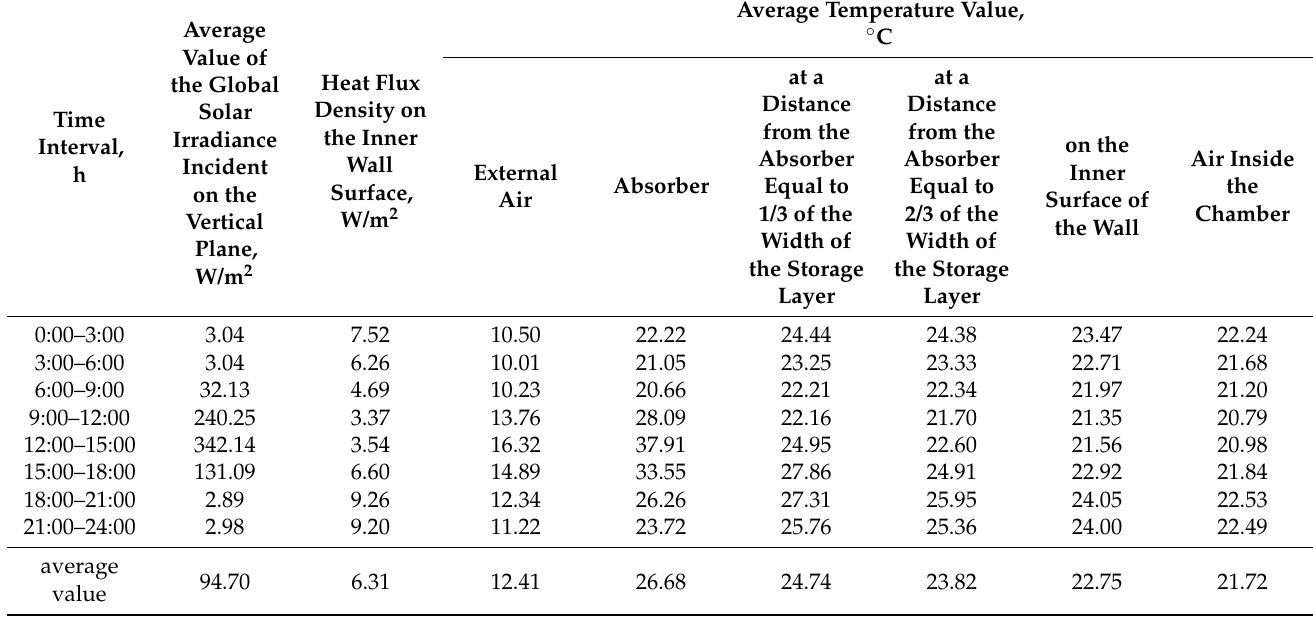
Table 5. Summary of the results of the tests carried out in October—the middle sector of the